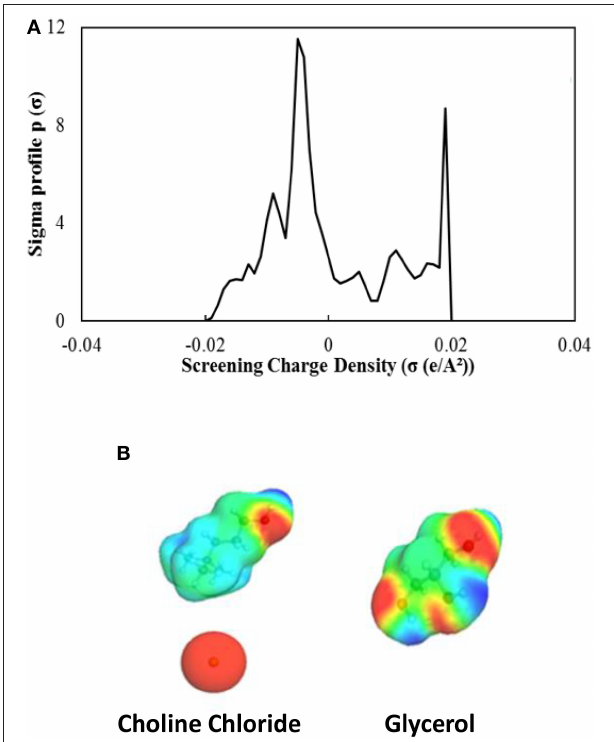
FIGURE 7 | (A) The sigma profile and the (B) sigma surface (colored molecule diagrams) of the ChCl-Gly DES (calculated using COSMO-RS). The sigma surface represents the charge from negative (red) to positive (blue), where neutral is represented by green. The sigma profile, a weighted sum of all the profiles of all components, has two large peaks indicating both strong negative and positive screening charges in the mixture.